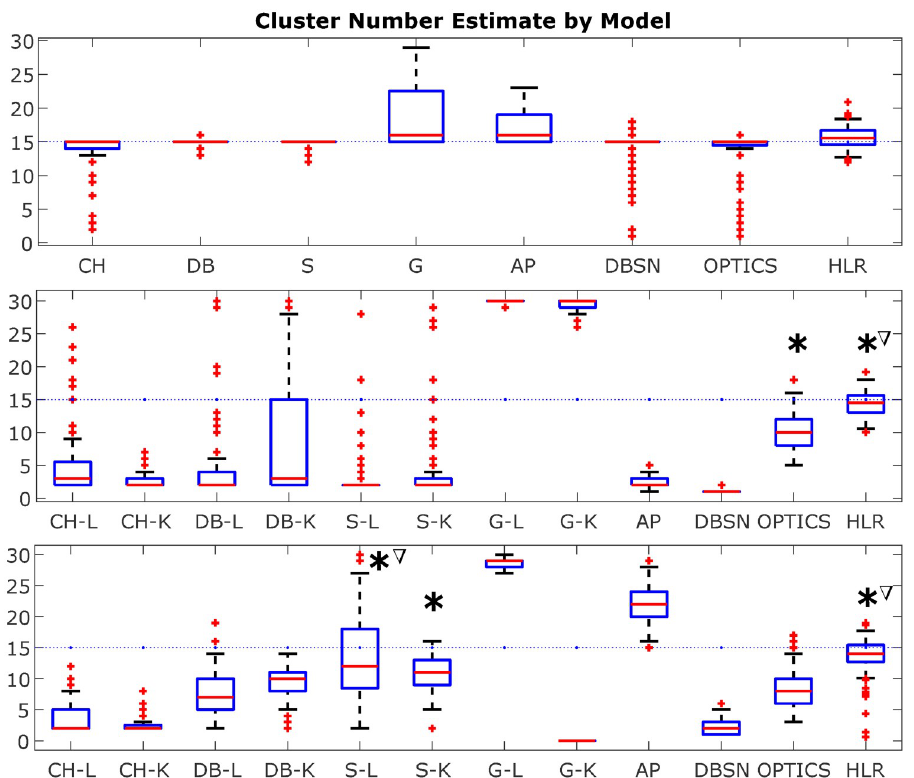
Fig 8. Boxplot comparing cluster number estimation models for single cluster number scenario ( ^ y ¼ 15 ). The upper, mid and lower plots pertain to results for ideal reference data, texture image data, and Wikipedia embedded text data, respectively, representing 100 clustering instances in each case. Ground truth is ^ y ¼ 15 clusters (blue dotted line). Asterisks for image and text data boxplots denote statistical significance with respect to the distribution of HLR being different from comparator models without asterisks, by the Friedman test ( p � 0.0001). Triangles denote statistical significance by one-way ANOVA for comparison. Boxes: lower bound Q1 quartile, upper bound Q3 quartile; whiskers: length bounded by (Q3-Q1) interquartile range. Model abbreviations: Calinski-Harabasz (CH); Davies-Bouldin (DB); Silhouette (S); Gap (G); Affinity Propagation (AP); DBSCAN (DBSN); OPTICS (same); HLR (hierarchical linkage regression); linkage clustering (-L); k-means clustering